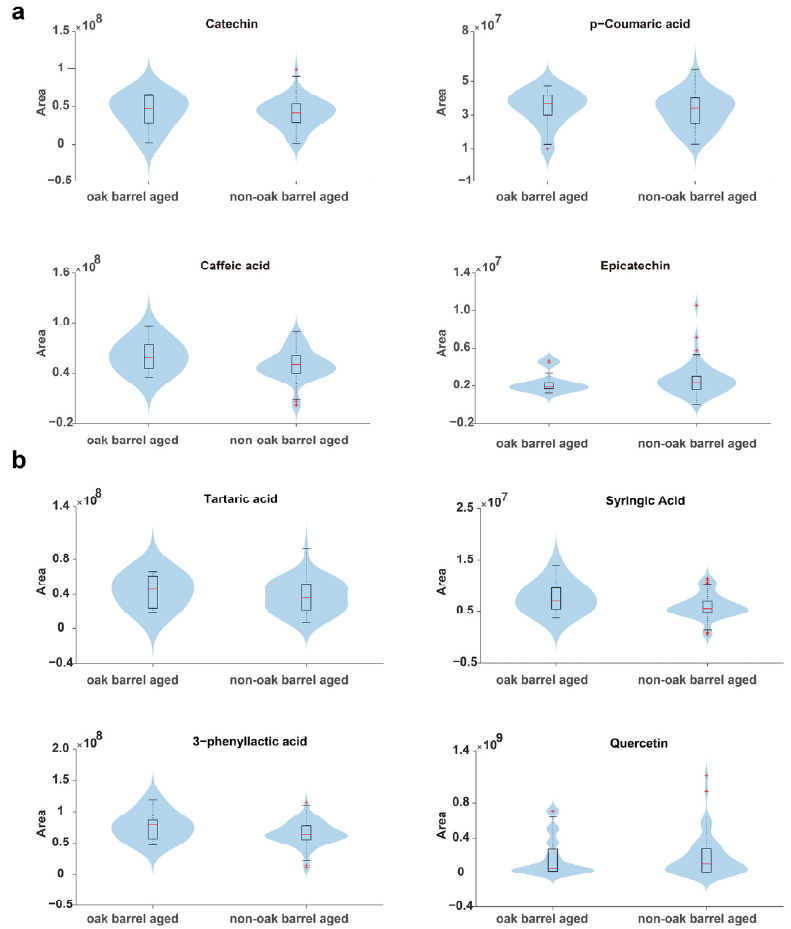
Figure 6. Violin plots of the relative contents of each compound in the wine samples for the ESI+ mode ( a ) and ESI − mode ( b ).